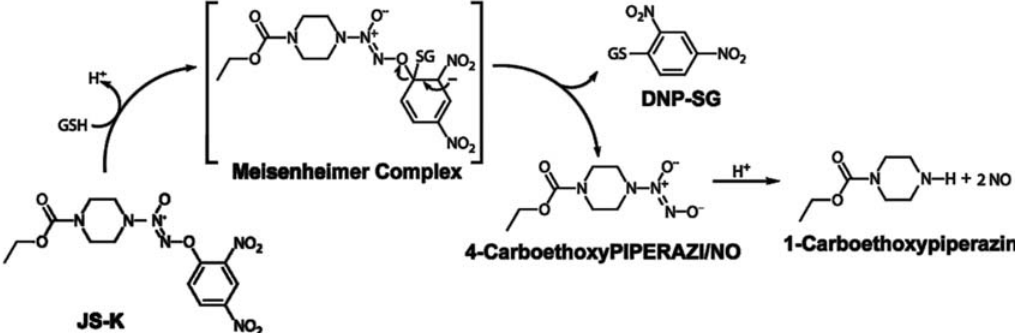
Figure 1: The structure of JS - K and release of